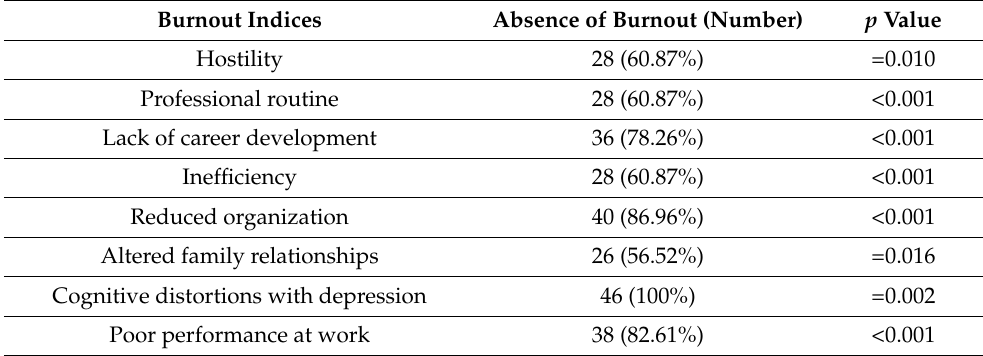
Table 4. Burnout